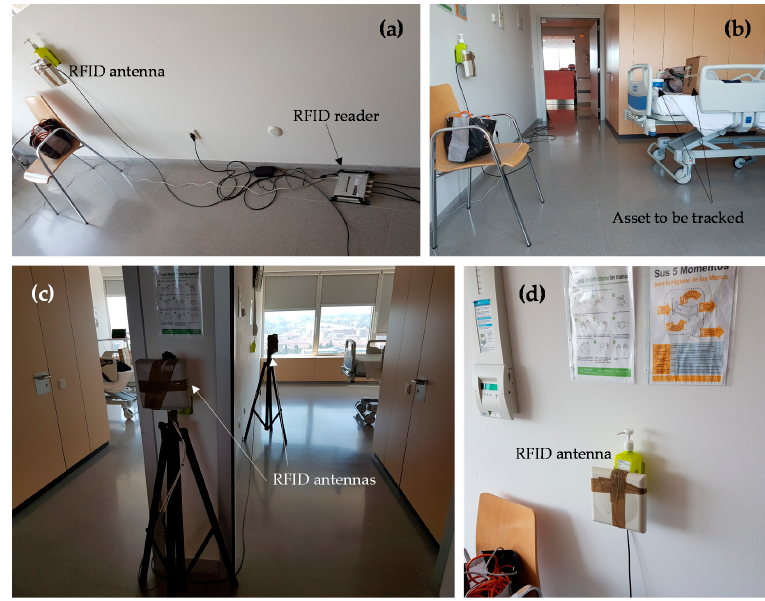
Figure 7. Pictures of the scenario where the RFID system has been deployed (rooms 312, 314, and hallway of the “Hospital Universitario Central de Asturias”). ( a , b ) Room 312. ( c ) Hallway and room 314. ( d ) Close ‐ up of the placement of a RFID antenna in room 312.